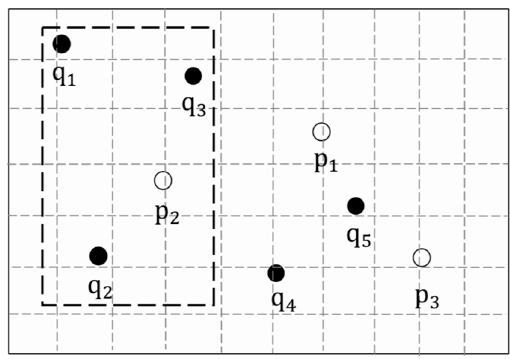
Figure 9. Aggregate subgroup.